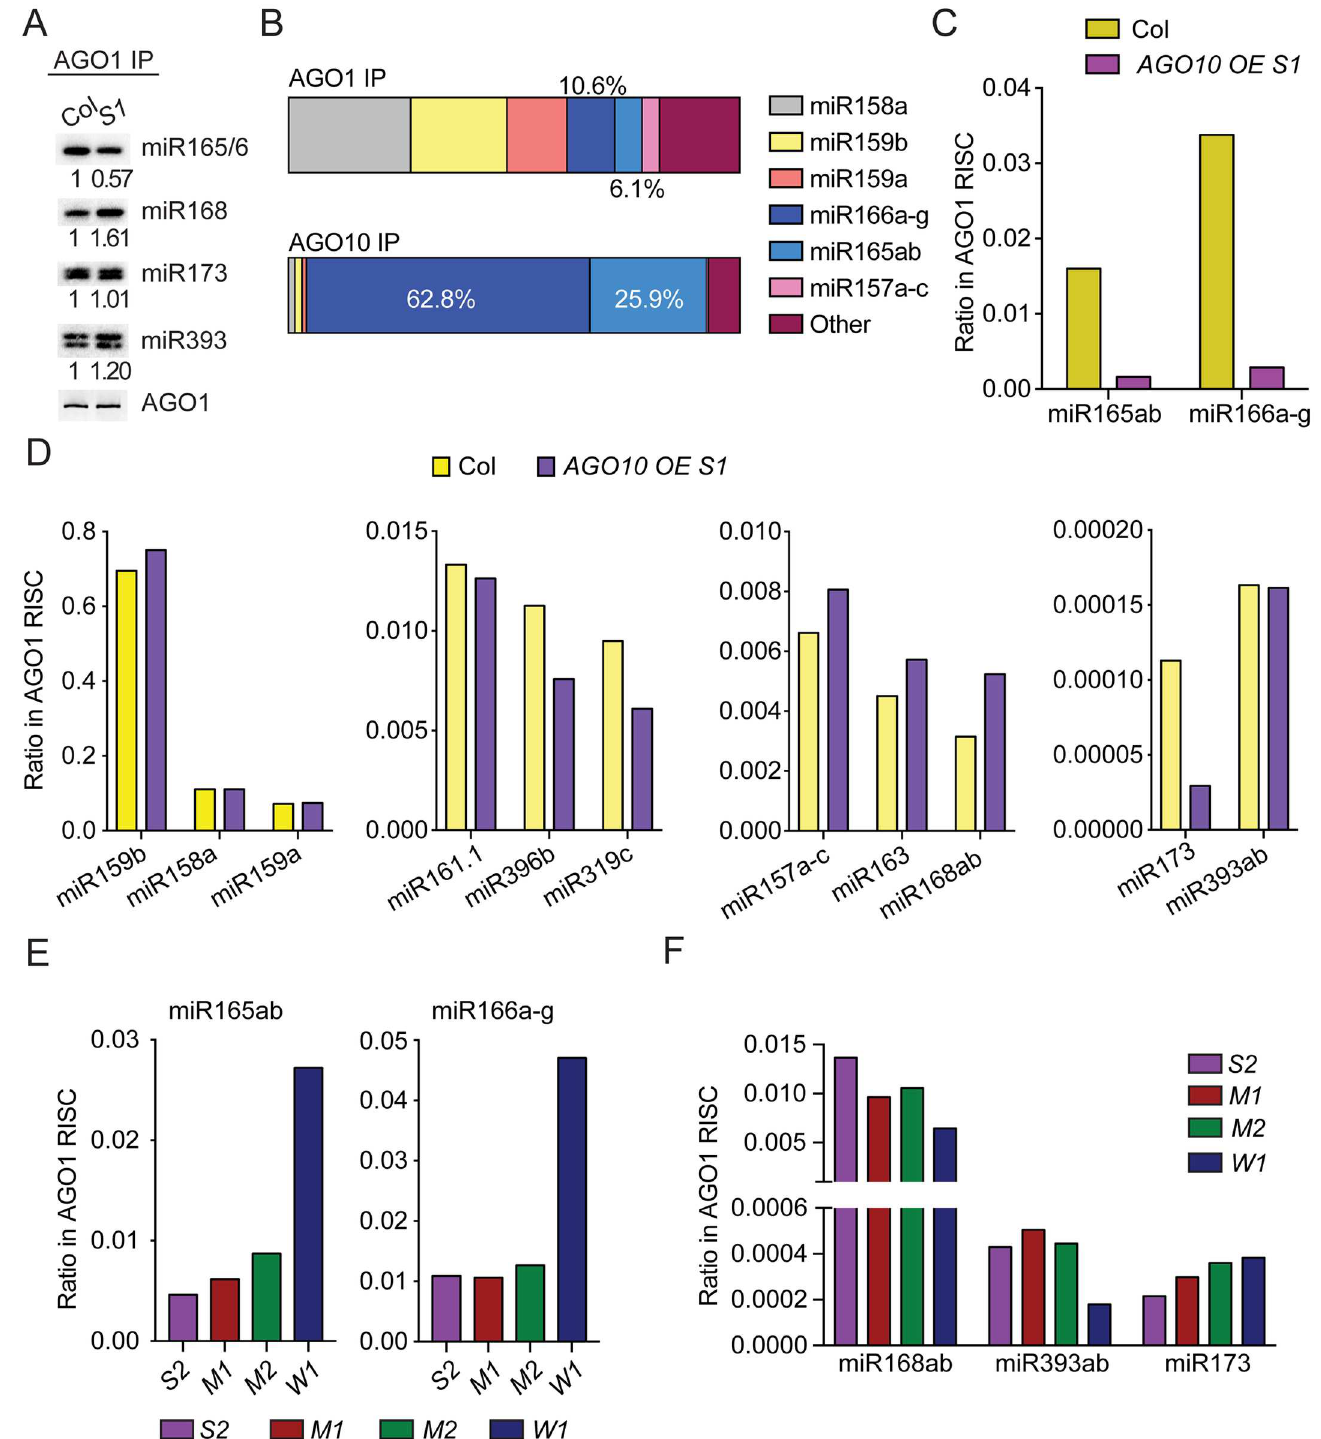
Fig 6. AGO10 overexpression results in sequestration of miR165/6from AGO1. (A) AGO1 was immunoprecipitatedfrom wild type (Col) and AGO10 OE S1 , and the associated RNAs were subjectedto northernblotting to detect four miRNAs. The AGO1 IPs were also subjectedto western blotting to determine the levels of the AGO1 protein. (B) Composition of miRNAs in AGO1 and AGO10 IP from AGO10 OE S1 . sRNA-seq was performed with three biologicalreplicates of AGO1 and AGO10 IP from AGO10 OE S1 . Reads corresponding to a particularmiRNA were quantified against those of all annotated miRNAs and shown as percentage of total reads. (C-D) The levels of variousmiRNAs in AGO1 IP from wild type (Col) and AGO10 OE S1 . The y -axis indicatesthe proportionof an individualmiRNA in the total miRNA pool in AGO1 IP. A few miRNAs from each of